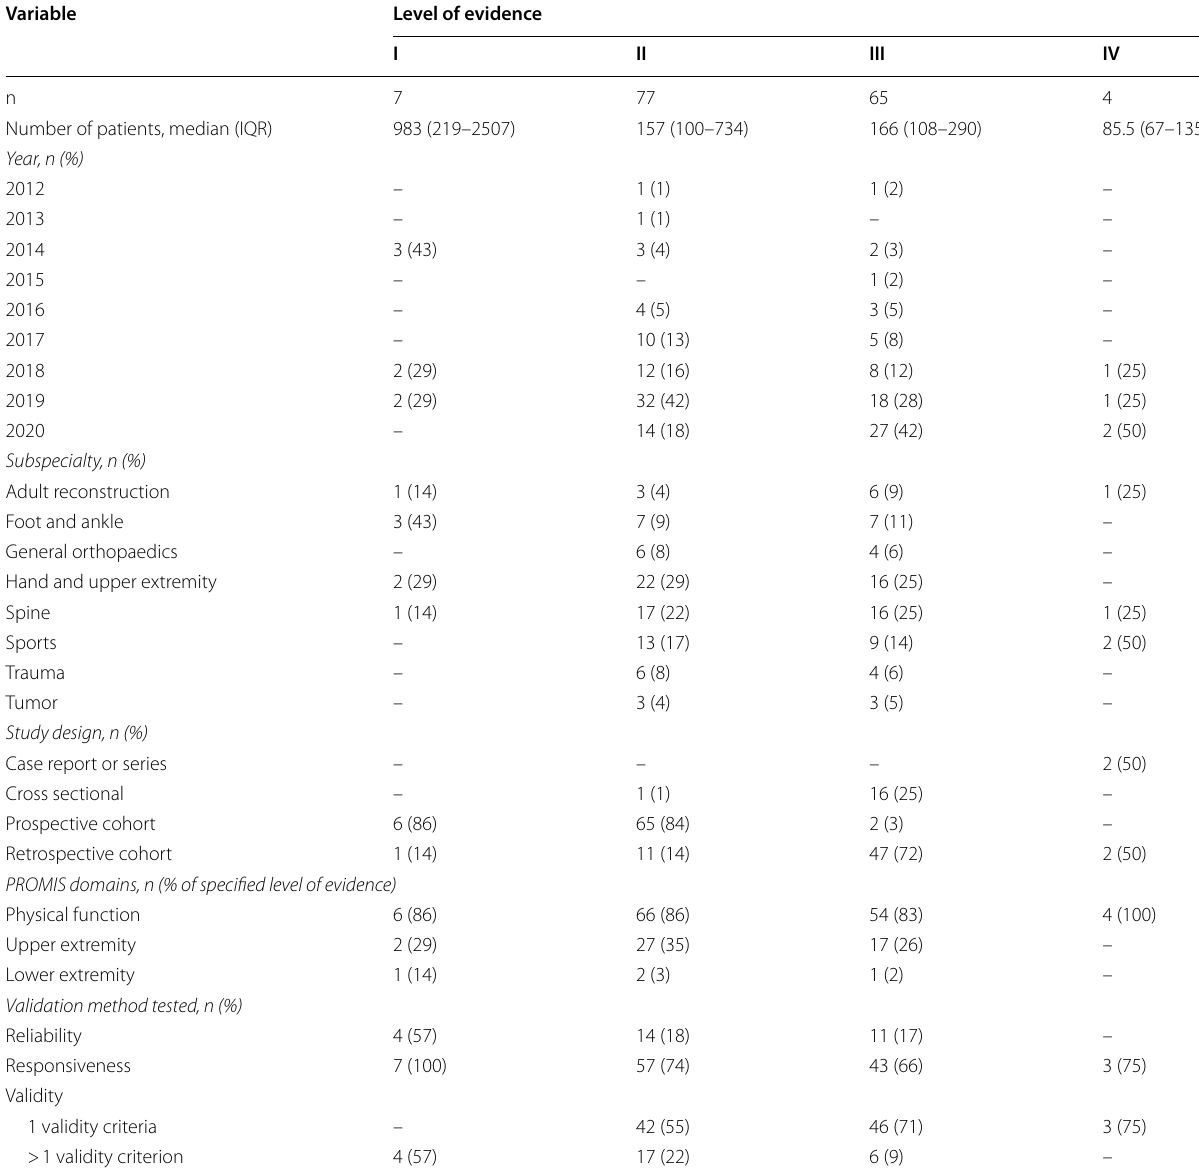
Table 6 Characteristics of publications validating physical health CAT PROMIS domains by level of evidence (includes physical function, upper extremity, lower